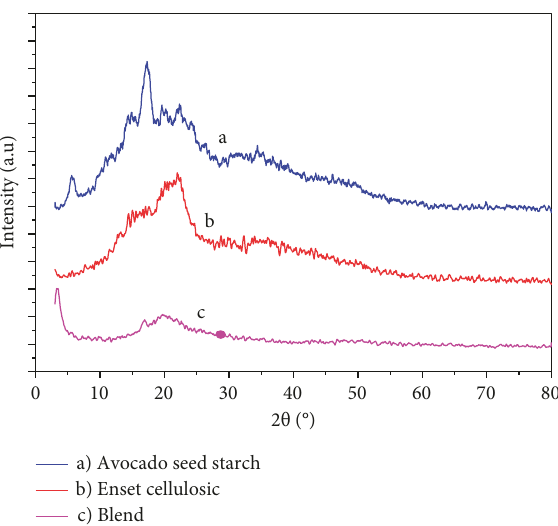
Figure 7: XRD plot of avocado starch, enset cellulosic, and the